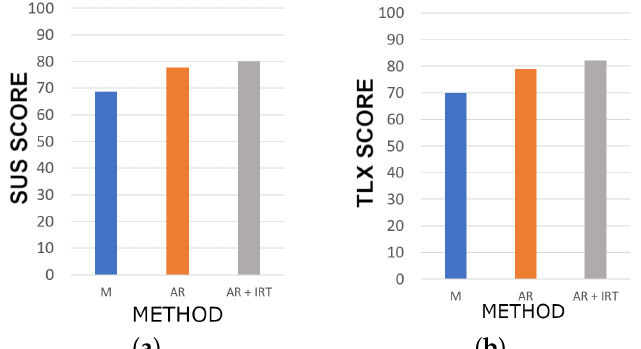
Figure 14. Questionnaires results carried out after the maintenance task: ( a ) SUS results; and ( b ) NASA results.